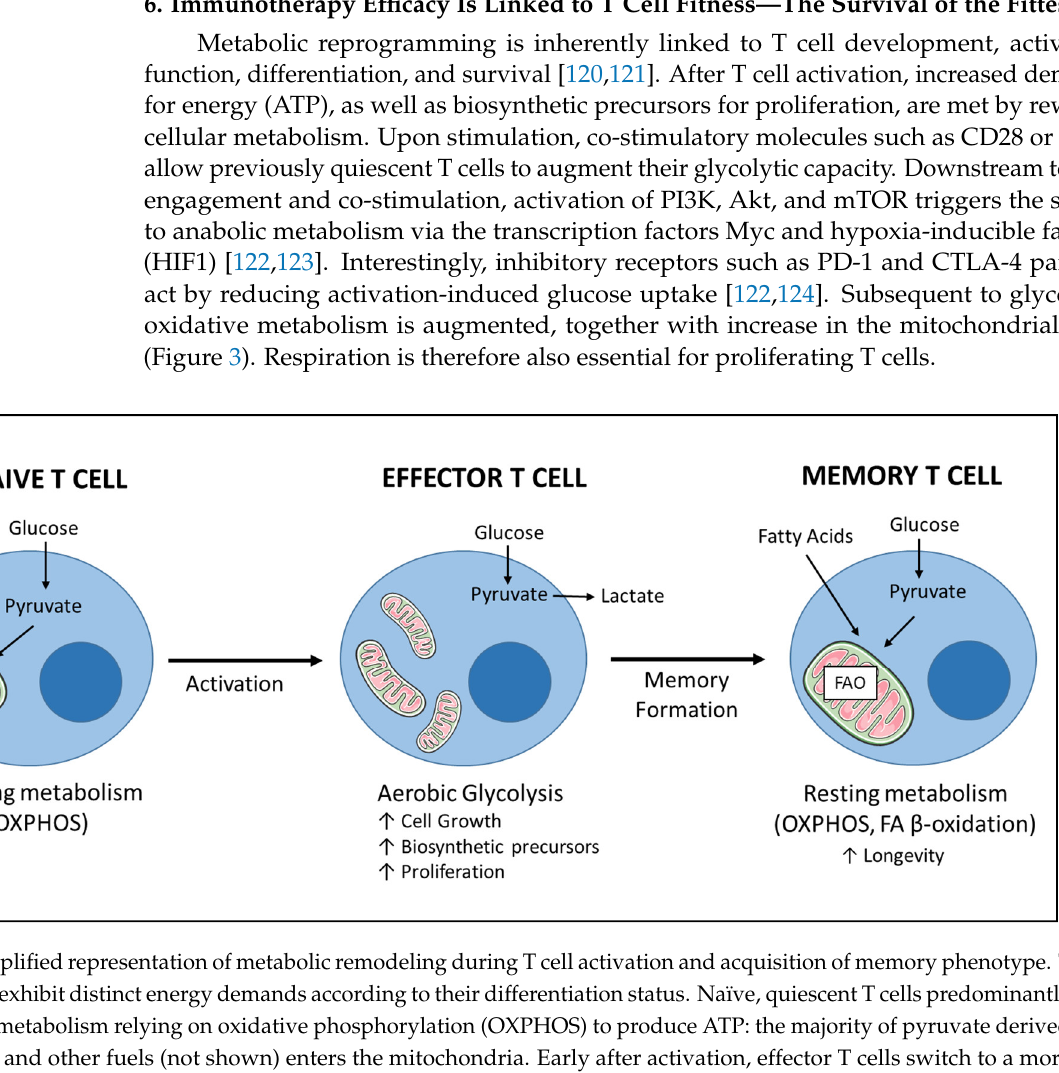
are adopting a so-called ”aerobic glycolysis”, otherwise referred to as Warburg